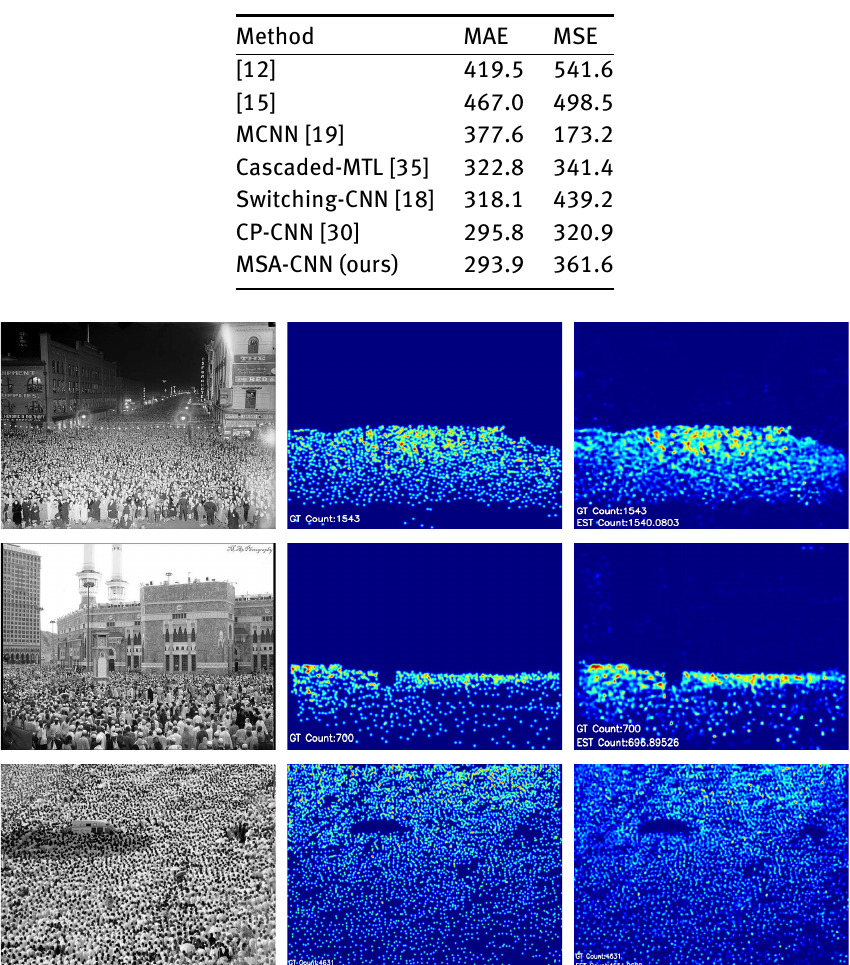
Figure 6: The density map estimated by MSA-CNN on the UCF_CC_50 dataset, the first column is test images, the second is ground truth density map, and the third is estimated density map by our approach (MSA-CNN).